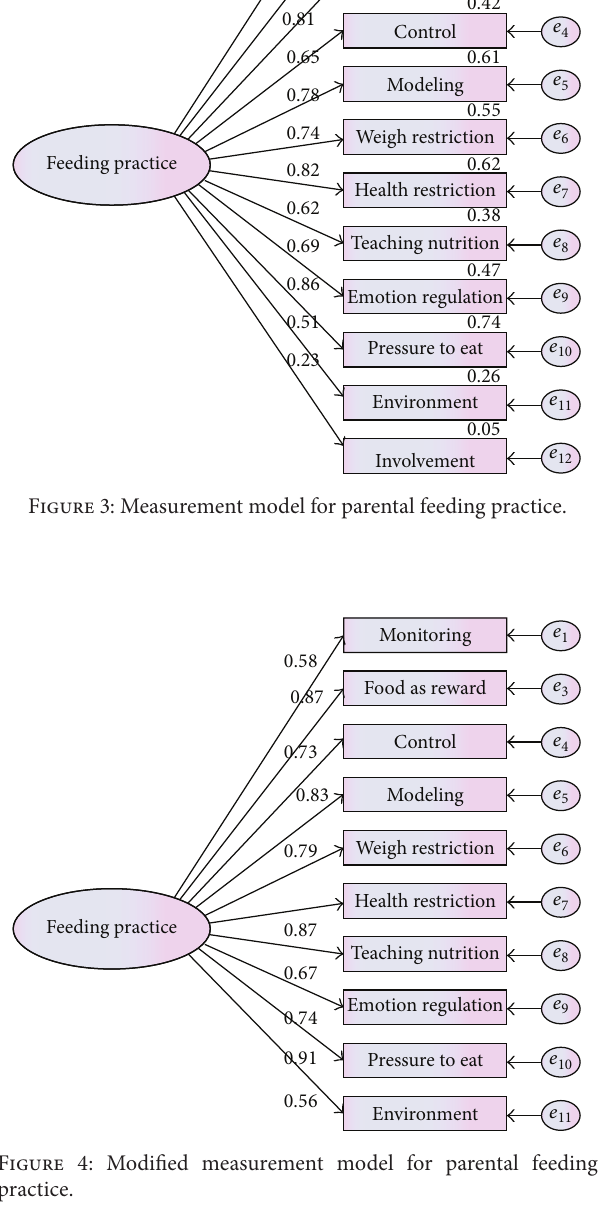
Figure 4: Modified measurement model for parental feeding practice.